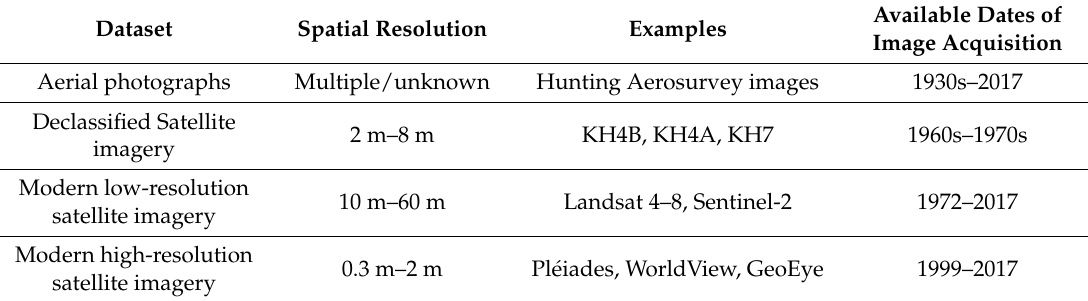
Table 1. Image datasets used by